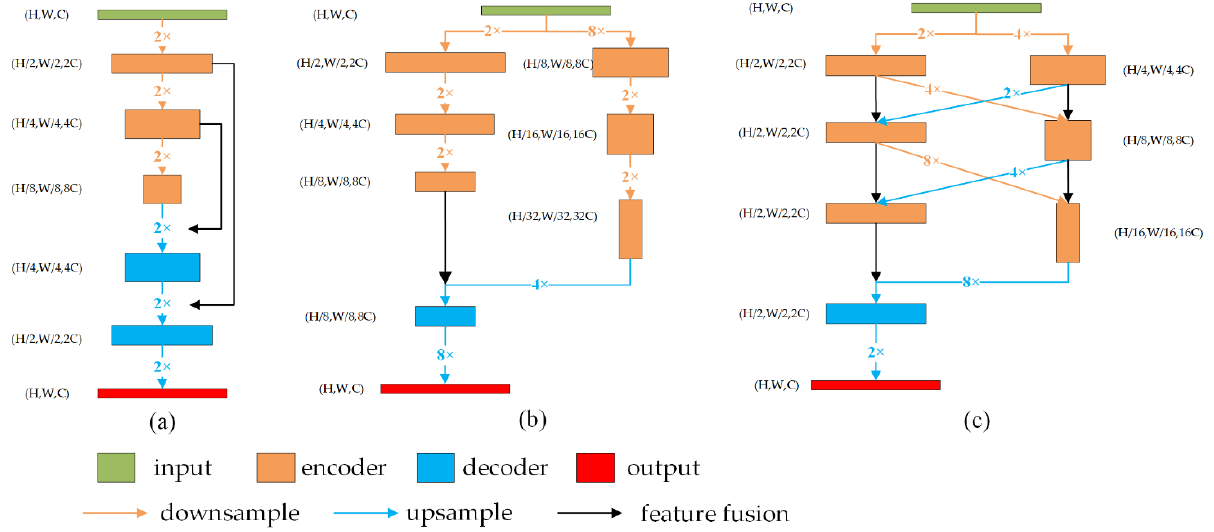
Figure 1. Different semantic segmentation network structures. We adopt direct addition as the feature fusion. ( a ) Typical U-shaped encoder–decoder structure represented by U-net [36]; ( b ) bilateral network structure represented by BiSeNet; ( c ) multi-resolution parallel network architecture represented by HRNet [37] .